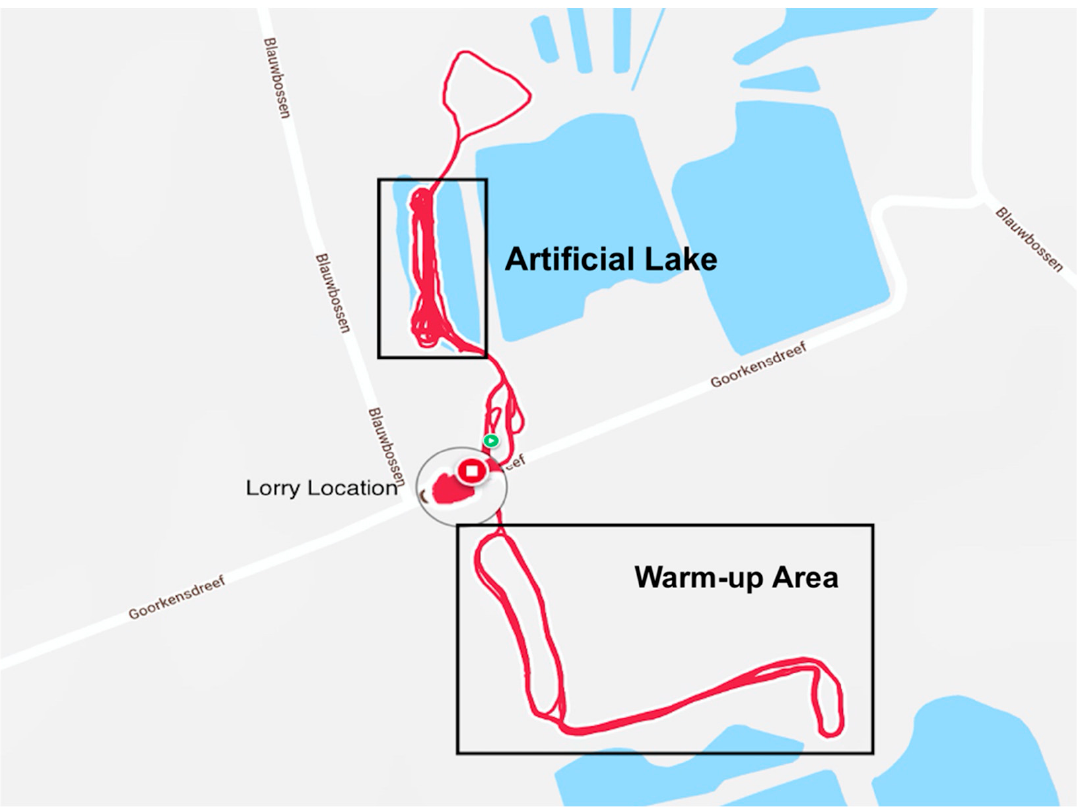
Figure 2. Map data; training venue highlighting the location of the lorry and warm-up area (WU), and the locations for RWST and CD (artificial lake).